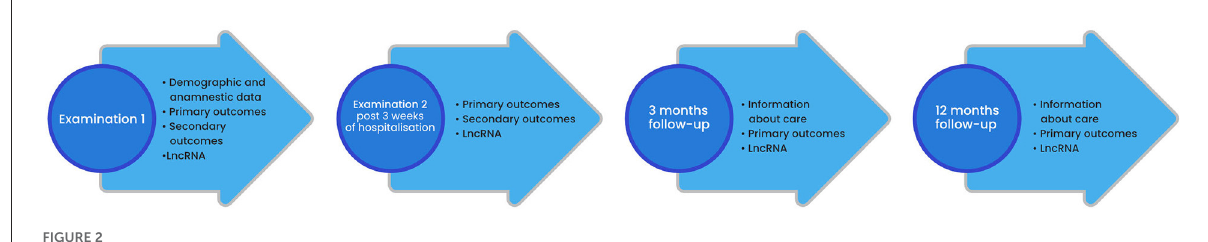
FIGURE2 Planned Recruitment and Randomization Process.